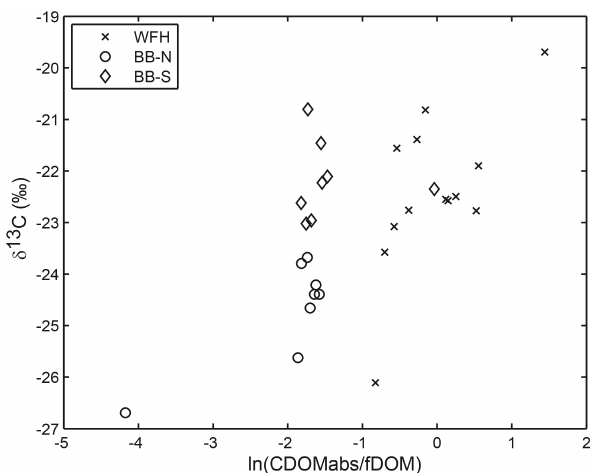
Figure 6. Isotopic signature versus CDOM absorption coefficient (340nm) divided by fluorescence for all sites at West Falmouth Harbor (WFH), North Barnegat Bay (BB-N), and South Barnegat Bay (BB-S). CDOM absorption coefficient per unit fluorescence presented on natural log